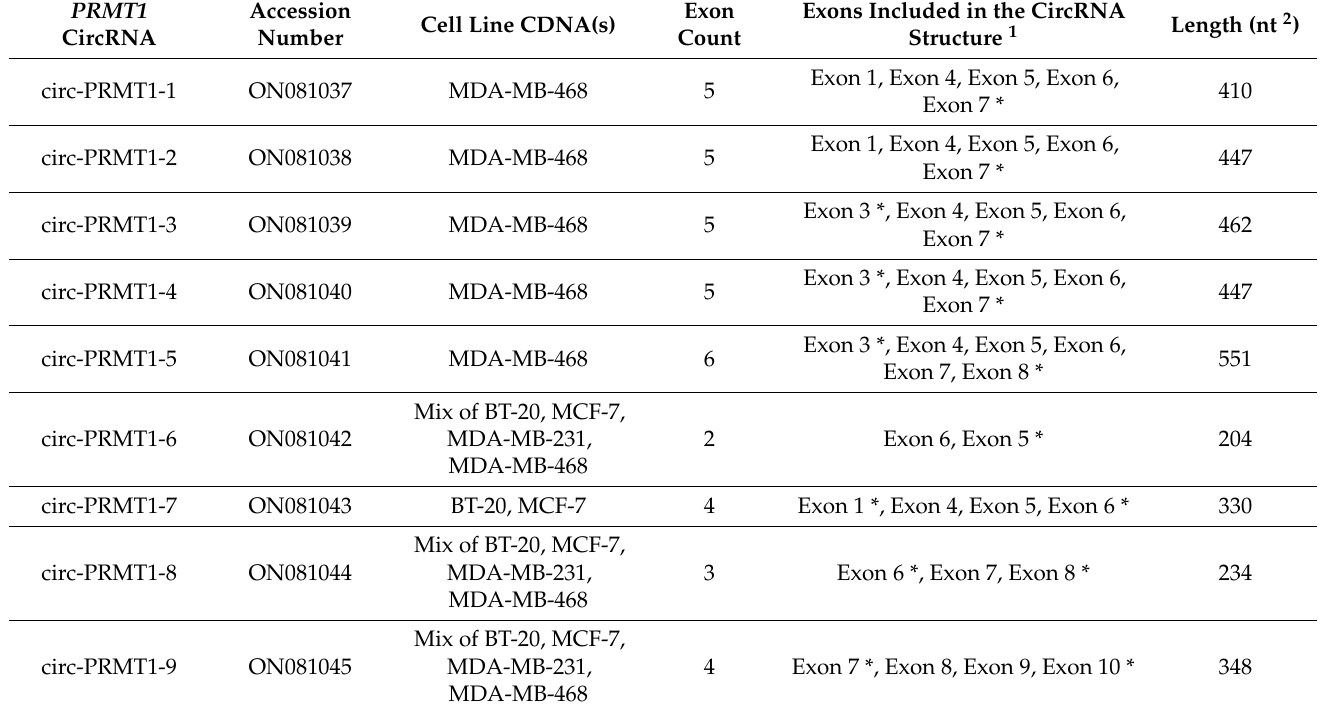
Table 1. Features of the 9 novel PRMT1 circRNAs that were identified and their GenBank ® accession numbers. For each circRNA, the cell line cDNA(s) in which it was found expressed is shown, as well as how many and which PRMT1 exons they